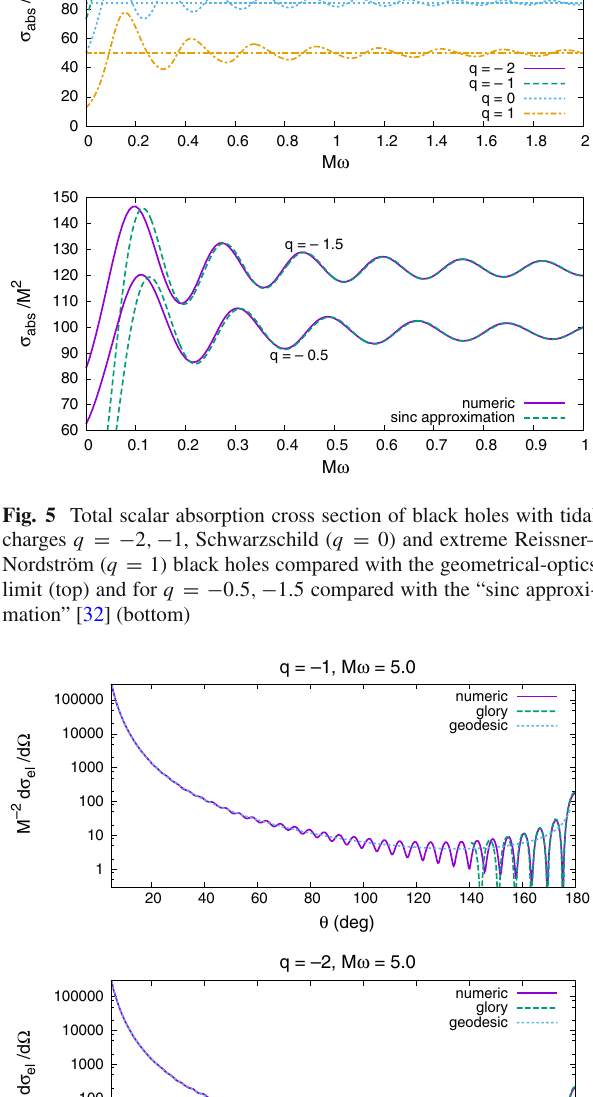
well with numeric results for θ (cid:3) 160 ◦ while the classical result is already very close to the numeric results in the range θ (cid:2) 20 ◦ . A comparison of the differential scattering cross section of black holes with tidal charges q = − 2 , − 1,